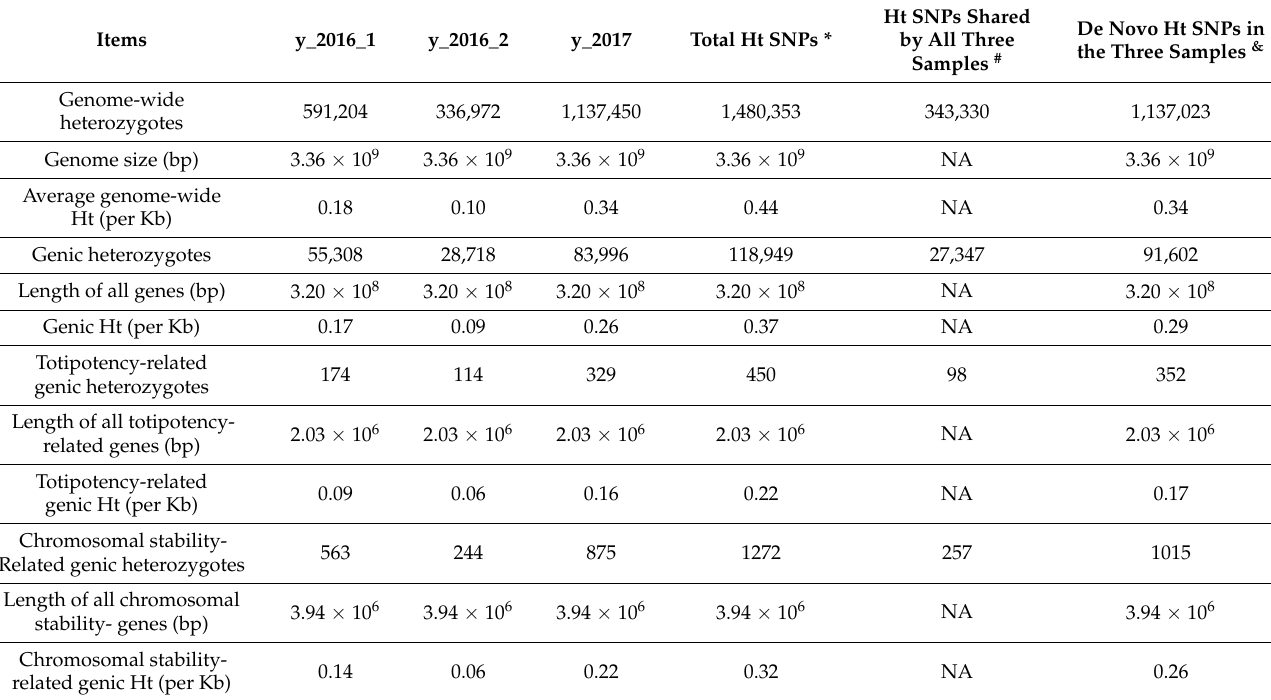
Table 1. The number of heterozygous (Ht) genetic variants and nucleotide diversity in three pooled callus-regenerated plantlets of Panax ginseng